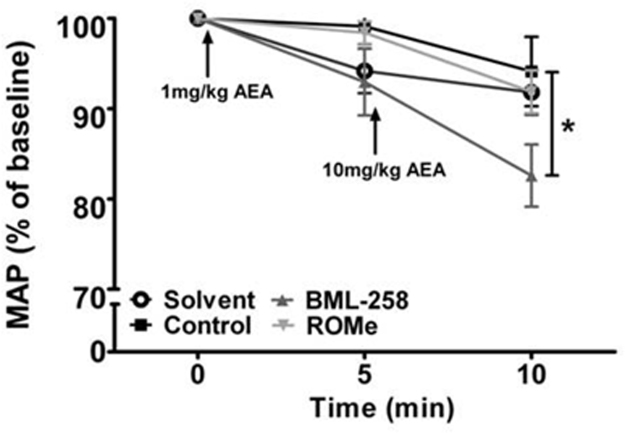
Recovery time of MAP following injection of AEA. Mice were pre-treated with either DMSO (control; n = 9), BML-258 (n = 5) or ROMe (n = 4) 24 h prior to the i.v. injection of AEA or Tocrisolve (solvent; n = 6). AEA was injected at increasing doses of 1 and 10 mg/kg at 5 min intervals. To assess the duration of the phase 3 response induced by AEA and the time taken to return to baseline, MAP was analysed 5 min after the injection of the relevant dose and expressed as percentage of baseline MAP. In all groups, MAP had recovered to baseline levels 5 min after injection of the lower dose of AEA. Data are expressed as mean ± S.E.M. *P < 0.05 vs. control.